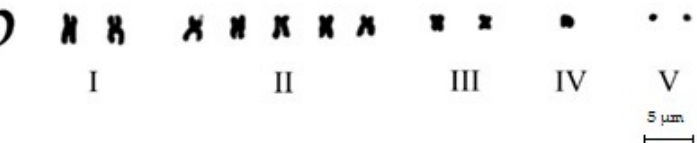
Figure 3. Karyotype of A. peninsulae : ( a ) the main set of 48 acrocentric A chromosomes and ( b ) variants of five (I–V) classes of B chromosomes. Formulas of Bs are 12.2.5.2.1.2.